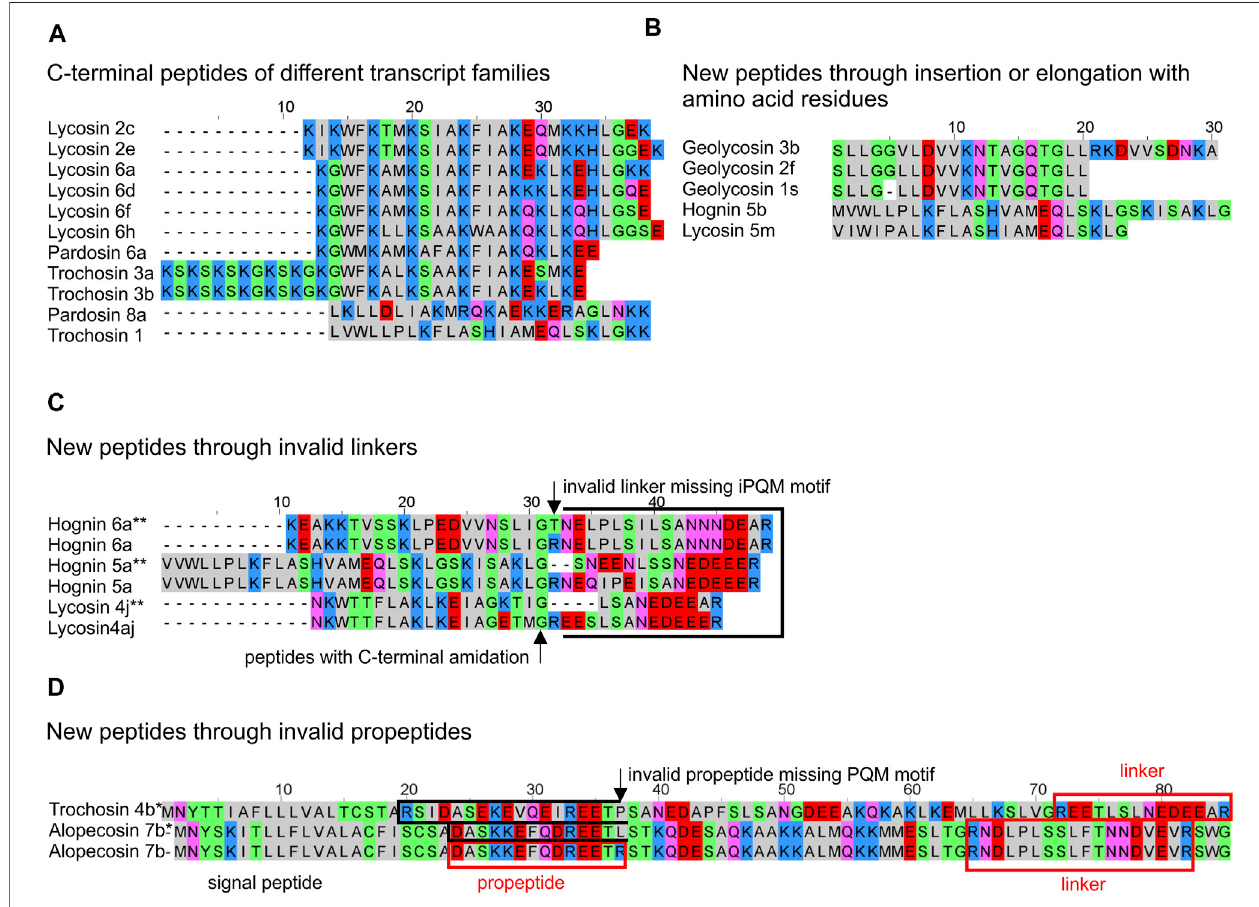
FIGURE 11 | Overview of different features of LPs from lycosids resulting in new peptide structures. (A) C-terminal peptides of identi fi ed transcript families are not C-terminally amidated and differ in N-terminal mutations, within the peptides, and C-terminal mutations, but also by elongations and insertions. (B) New peptides occur through insertion within the peptide, and/or elongation of the C-terminal peptide part. (C) Invalid linkers C-terminally of LPs may results in fused peptides. (D) Invalid C-terminiofpropeptides mayresult infusedpeptides.*theoreticalN-terminallyfusedpeptides,**theoreticalC-terminallyfusedpeptides.Cationicamino acidsare colored in blue, anionic amino acids in red, the corresponding C-terminal amid variants in pink, hydrophobic amino acids in black, and polar amino acids in green.